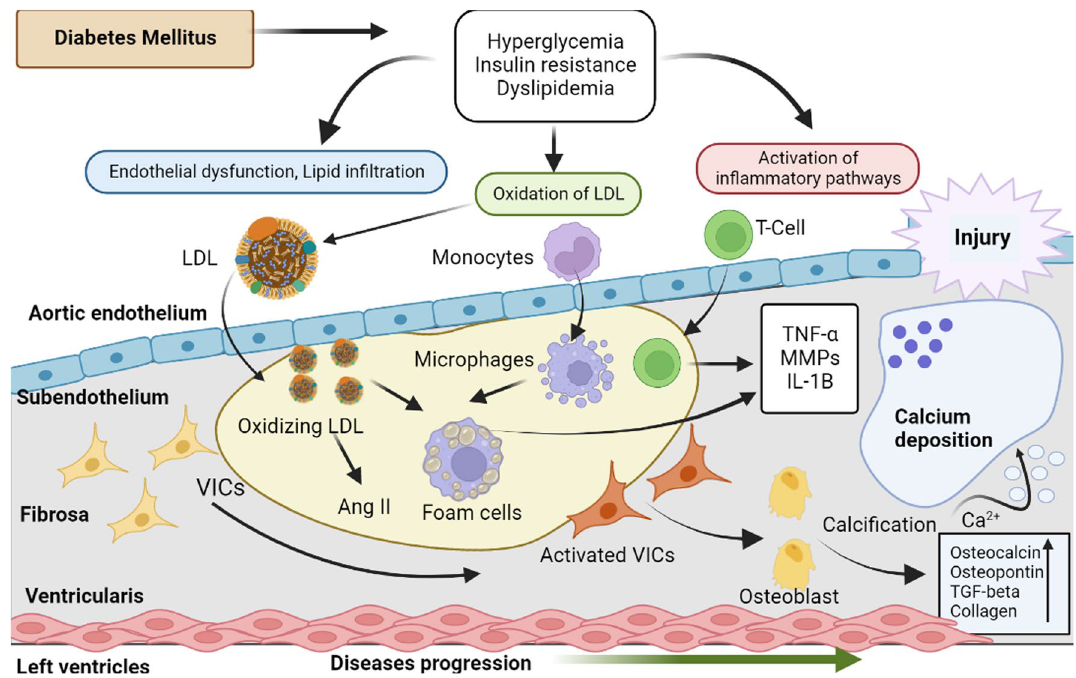
Fig. 5 Diagrammatic representation of the pathophysiological connection of diabetes mellitus and aortic